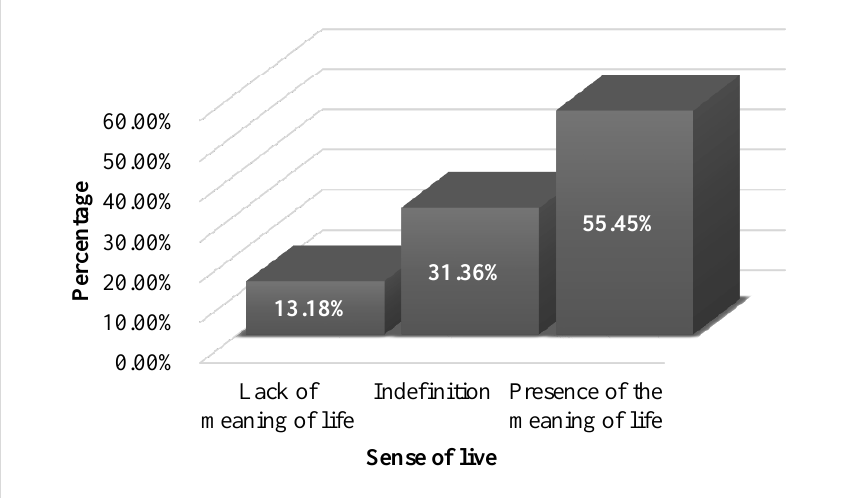
Figure 4. Sense of life of university students from